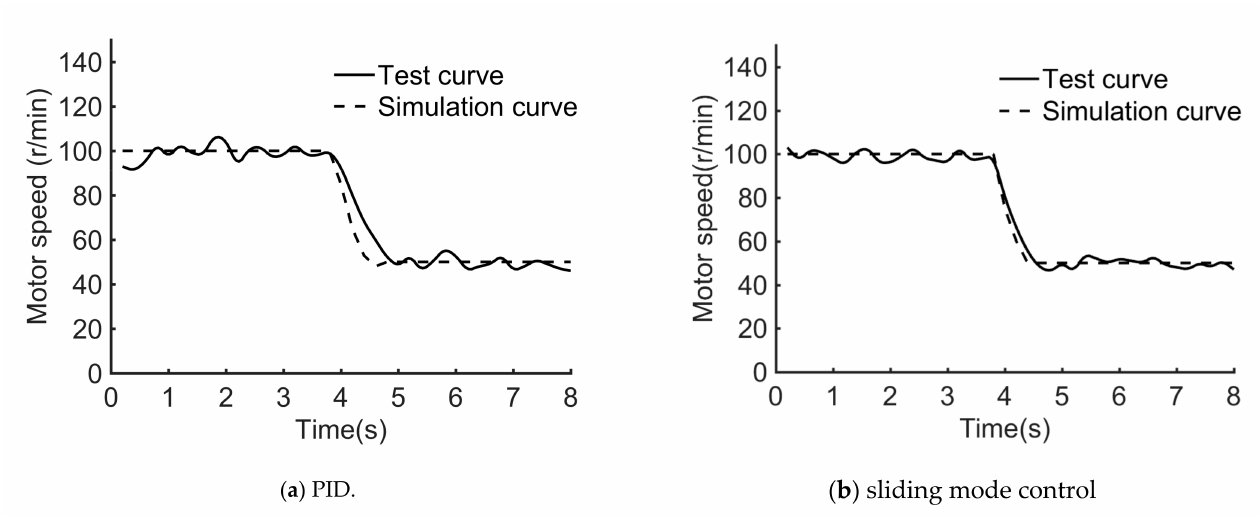
Figure 5. Response Curve of Step